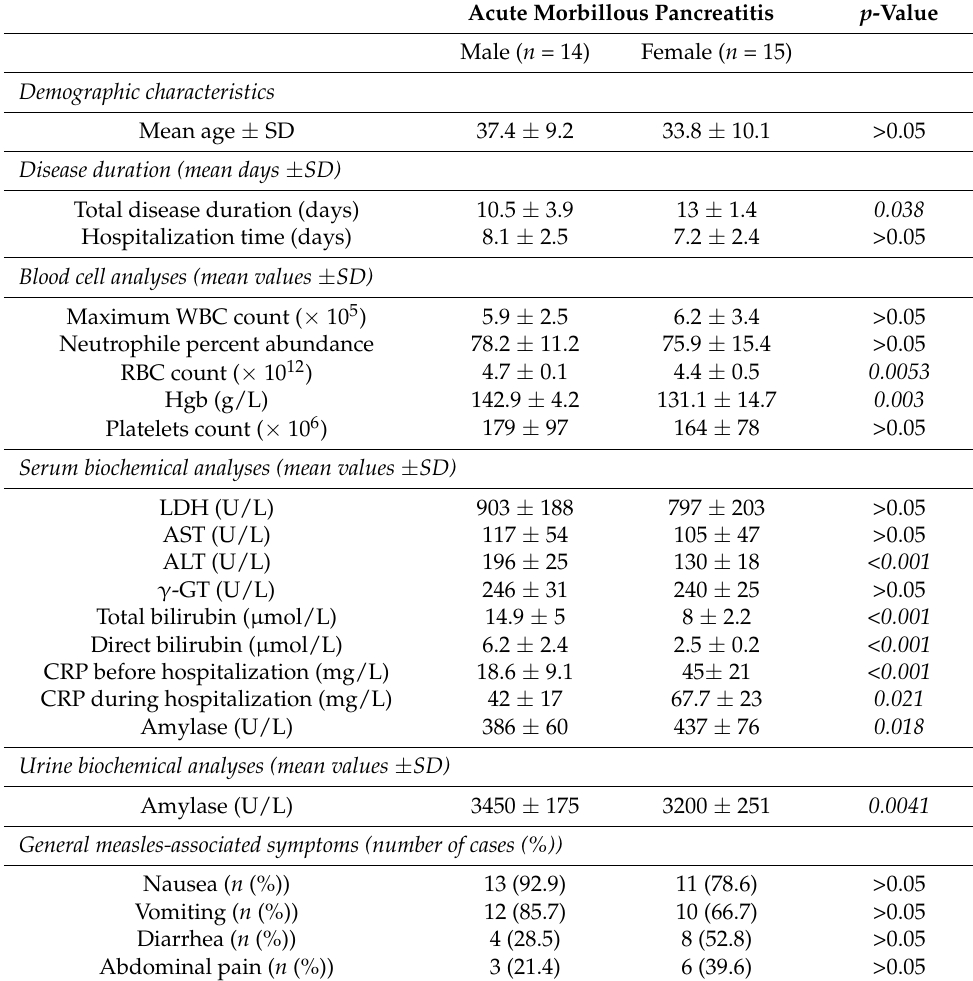
Table 2. Descriptive data and statistical analysis obtained from male and female subjects with acute morbillous